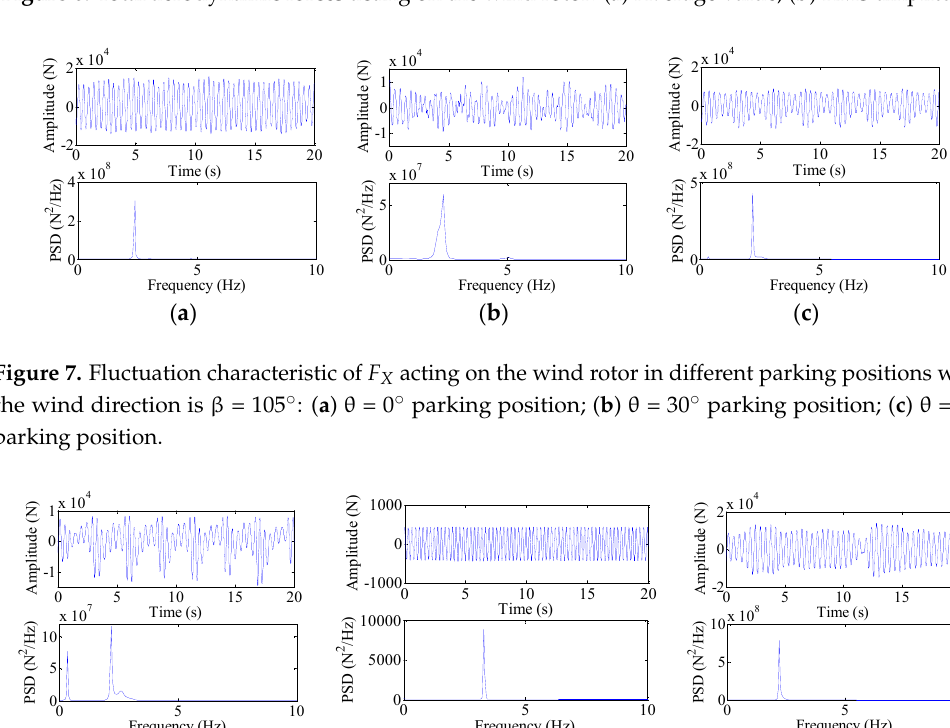
Figure 8. Fluctuation characteristic of F X acting on the wind rotor in different parking positions when the wind direction is β = ´ 105 ˝ : ( a ) θ = 0 ˝ parking position; ( b ) θ = 30 ˝ parking position; ( c ) θ = 60 ˝ parking position.